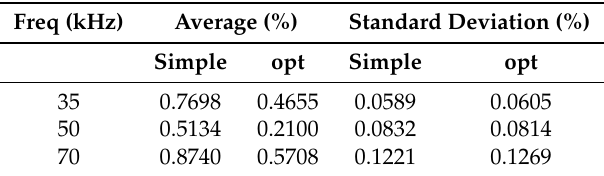
Table 5. Average and standard deviation of the power errors.